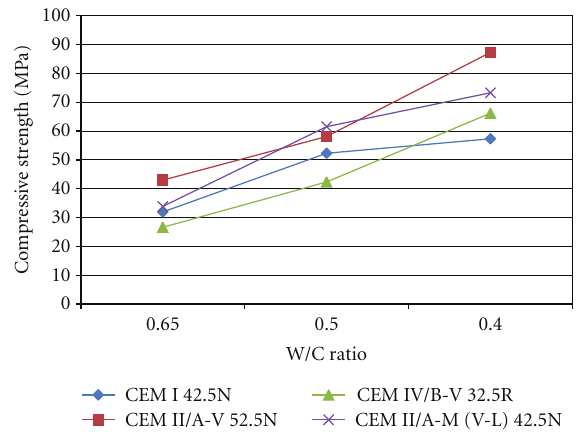
Figure 1: 28-day compressive strength for di ff erent cement types at di ff erent w/c